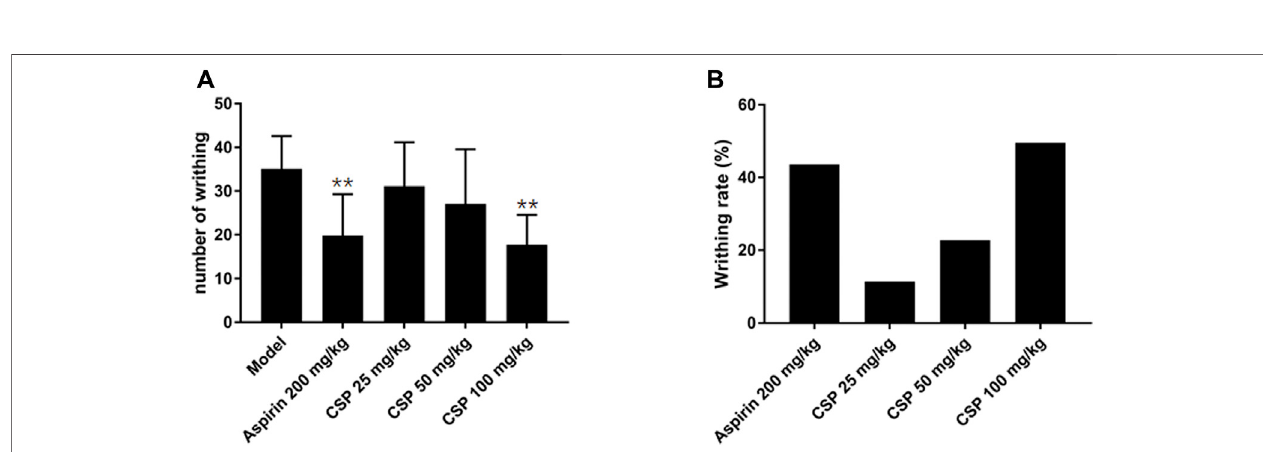
Frontiers in Pharmacology |